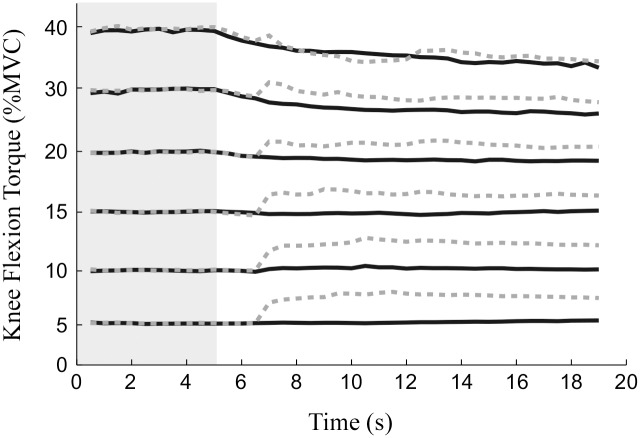
Average knee flexion torque.TAP trials (light, dotted lines) and NTAP trials (dark, solid lines) are illustrated for each target torque level as a percent of the MVC. Shaded area represents the time visual feedback was given to the subjects.